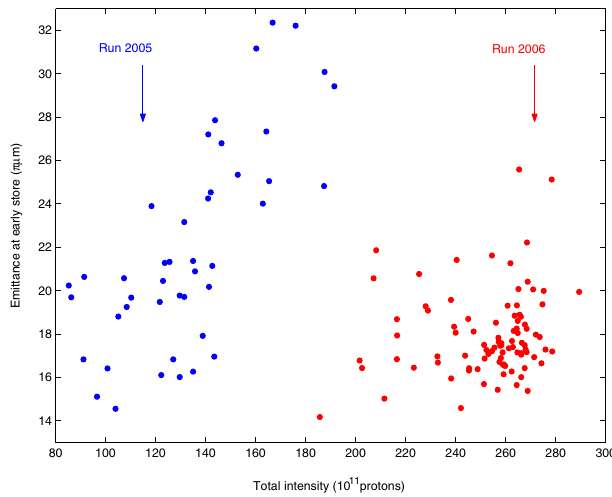
FIG. 1. (Color) The 95% normalized beam emittance versus total beam intensity for different RHIC fills in 2005 and 2006 100 GeV polarized proton runs. The emittance is calculated from the average ZDC coincident rates of the experiments PHENIX and STAR, at the early store.